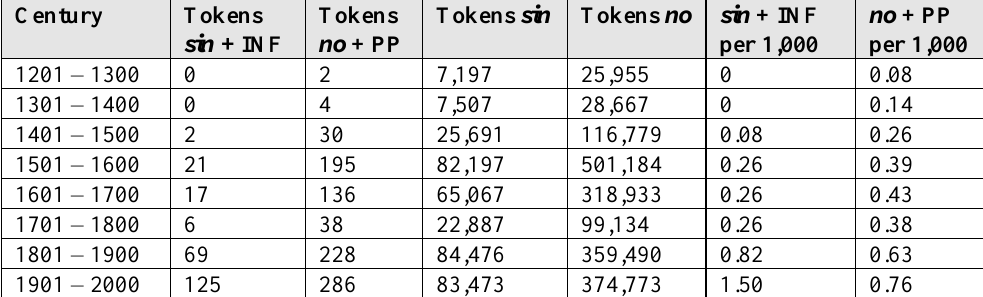
Table 3. Frequency of adjectival sin + INF and no + PP by